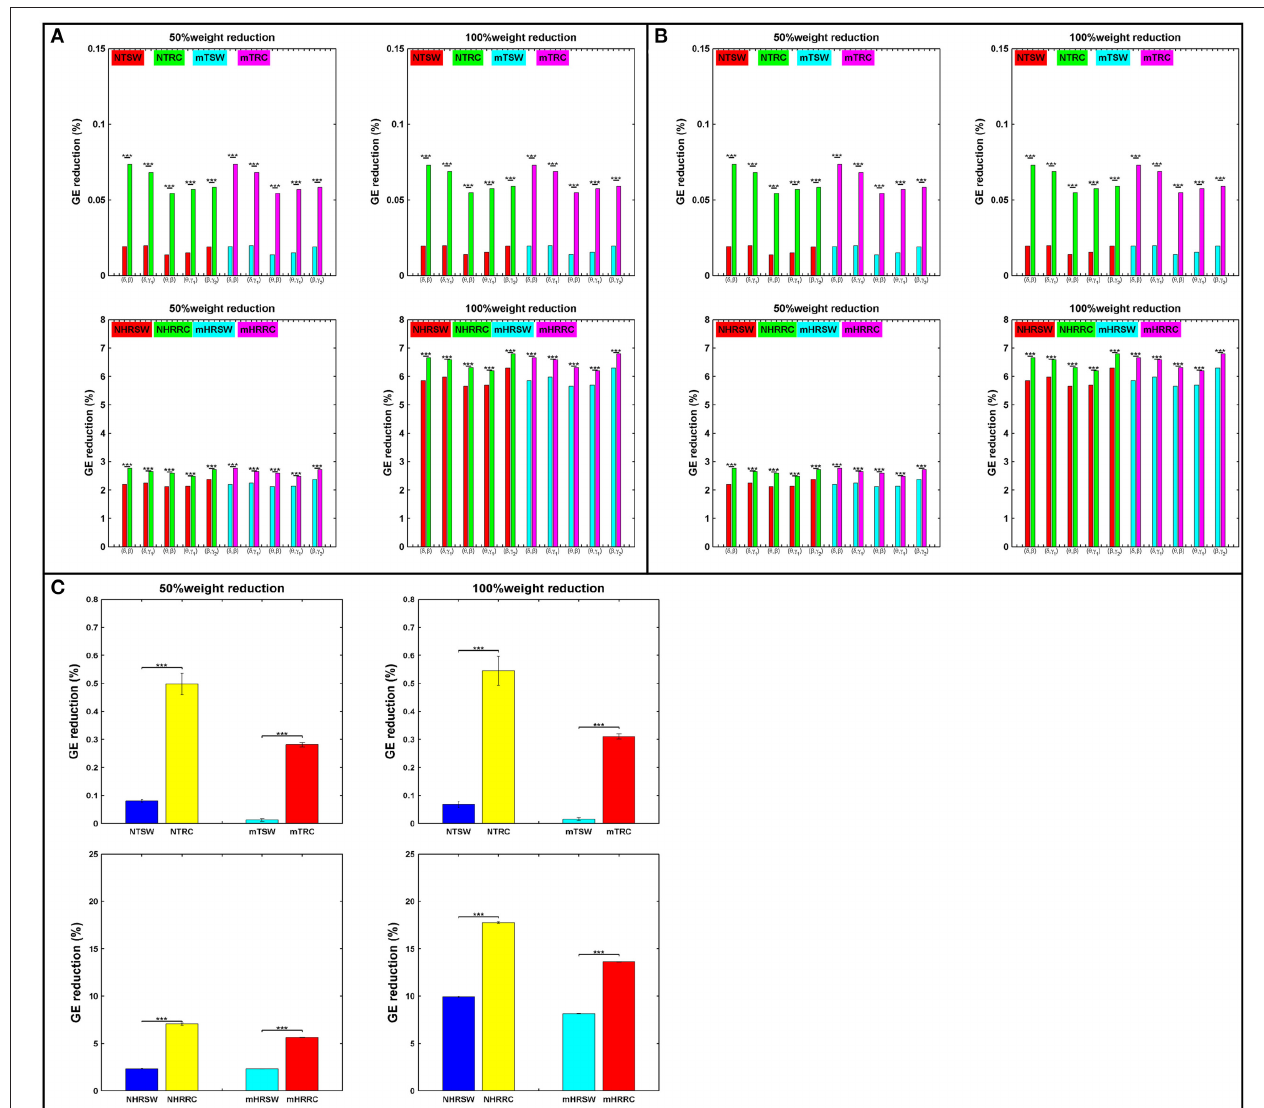
FIGURE 6 | Percent reduction in total GE on SW and RC brain models for (A) IFCG, (B) CFCG, and (C) ICFCG after attacking targeted interconnected nodes (T) or hubs connected to random nodes (HR). Control: NTSW and NHRSW—red; NTRC and NHRRC—green; mTBI: mTSW and mHRSW—cyan; mTRC and mHRRC—magenta. In case of (C) the color-bars are different, Control: NTSW and NHRSW—blue and NTRC and NHRRC—yellow; mTBI: mTSW and mHRSW—cyan and mTRC and mHRRC—red. The scale in (A,B) is the same. Network attack: select 50% of connections that intra-connect hubs within either RC or SW backbone or 50% of connections that inter-connect hubs with the rest of the network. All comparisons reached statistical significance ( p -value: *** < 0.001).